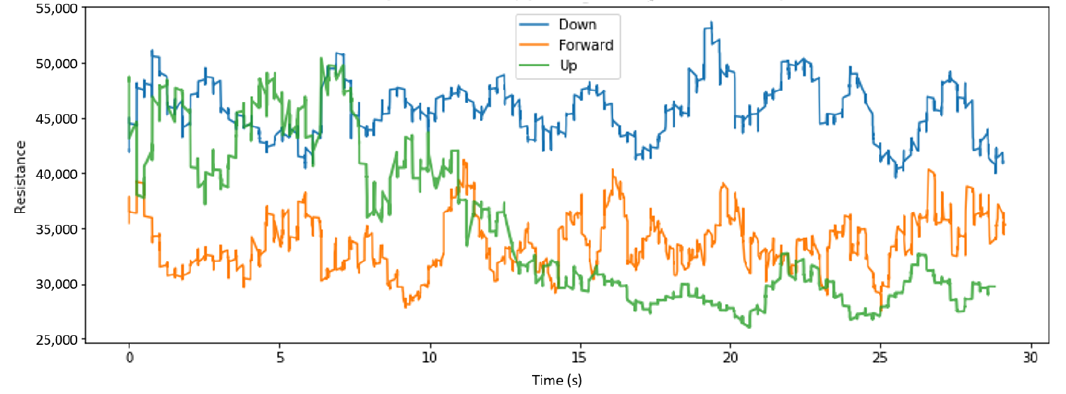
Figure 4. With low placement of short sensor, head tilt filtered data.